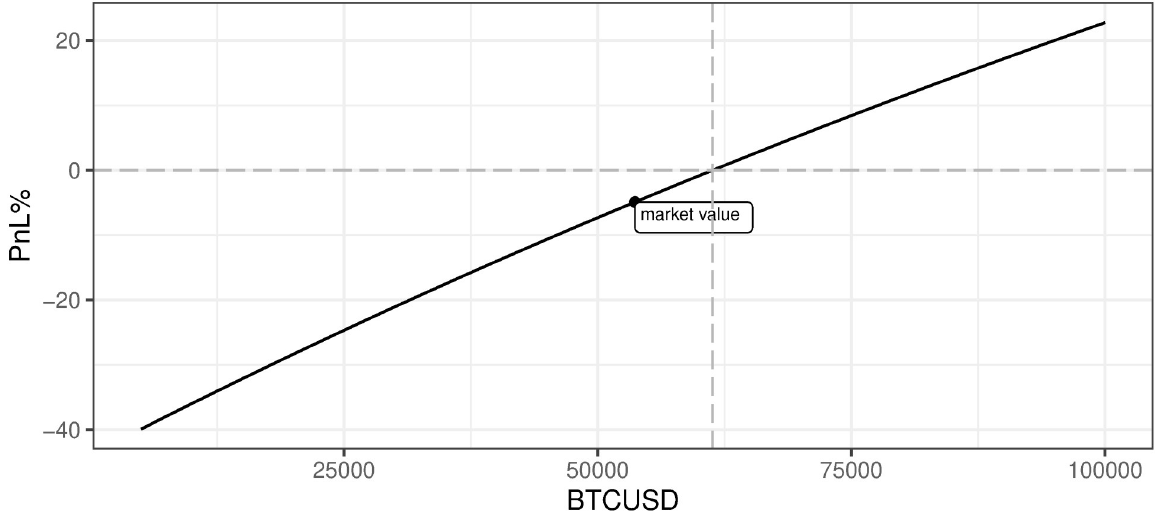
Fig 20. BTC mining profitability (PnL%) for different BTCUSD prices. Note: PnL%, calculated according to the formula 6. BTCUSD hypothetical prices range from 5000 up to 1e+05 USD. The market value point describes the current state of market mining efficiency assuming the parameter outlined in the section Values of variables as of 2021/12/03. Source: own calculations based on data described in the section Crucial assumptions and